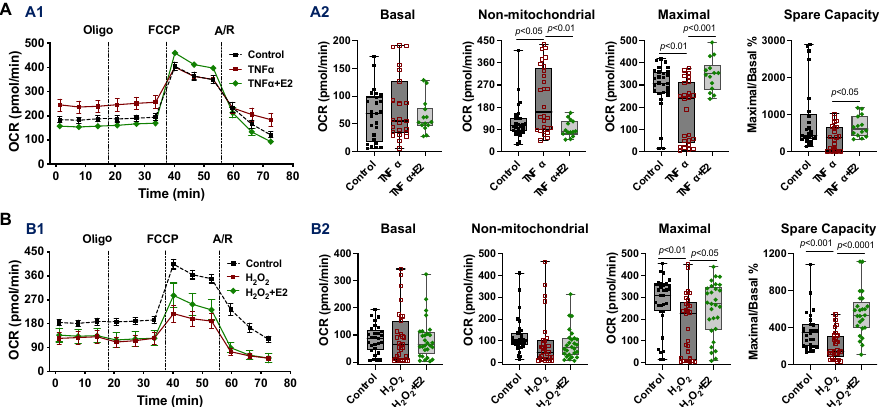
mitochondrial metabolic function was also protected by E2 usage (Figure 5B). E2 did not affect the mitochondrial bioenergetic response in cardiomyocytes isolated from male adult mice without stress (Supplemental Figure S2).